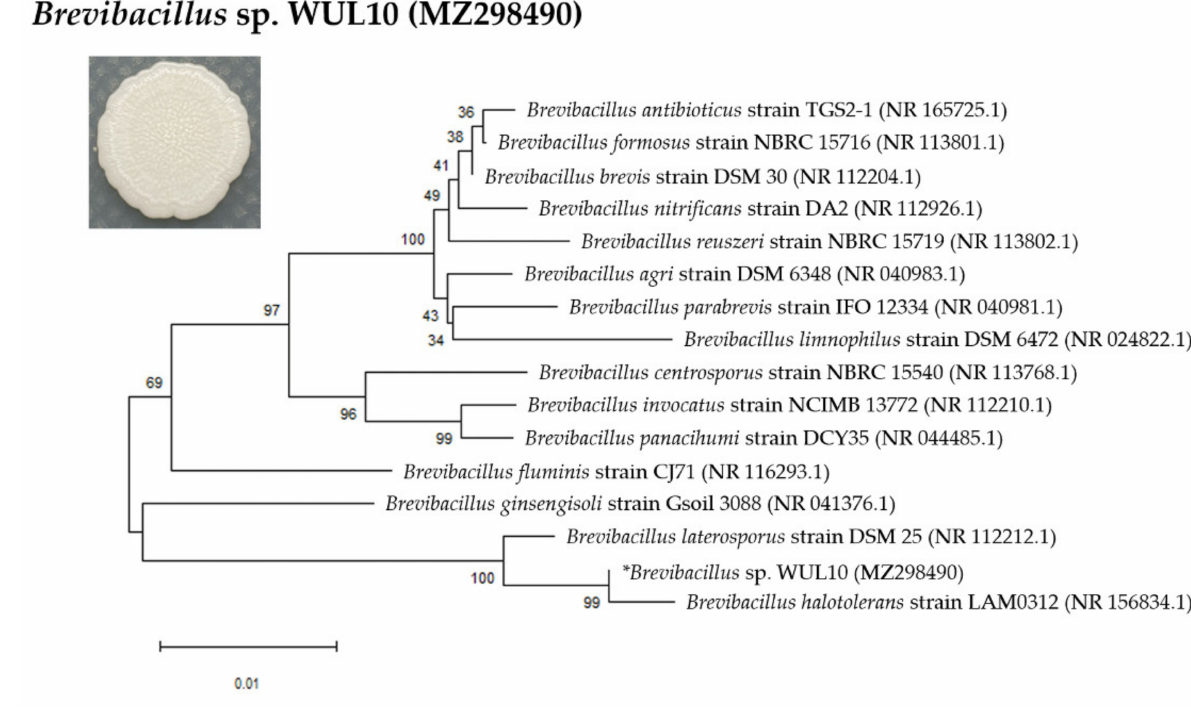
Figure 2. Phylogenetic tree and colony morphology of Brevibacillus sp.